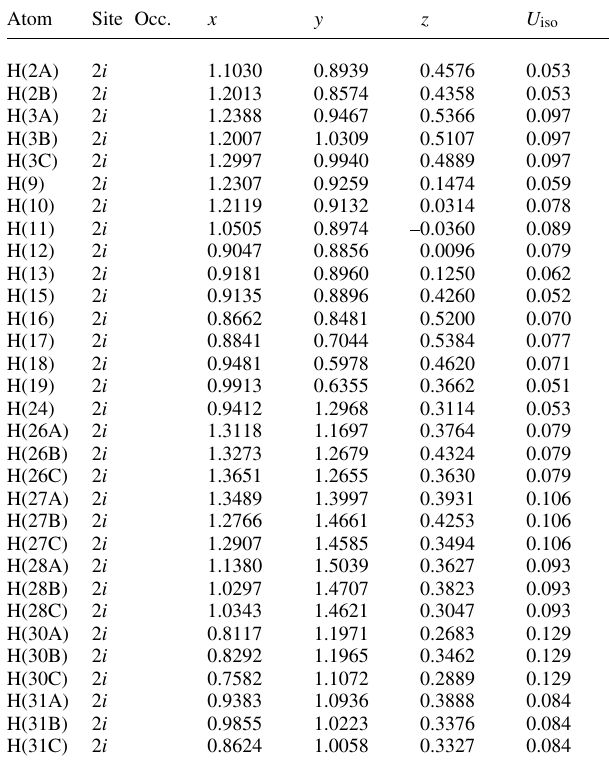
Table 2. Atomic coordinates and displacement parameters (in Å 2 )